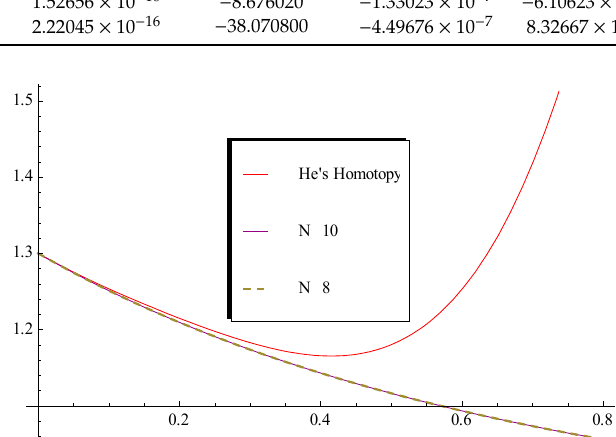
   u at different N with He’s Homotopy solution. Figure 6 . Approximate solutions N Figure 6. Approximate solutions u N ( τ ) at di ff erent N with He’s Homotopy solution. Figure 6 . Approximate solutions at different N with He’s Homotopy solution.